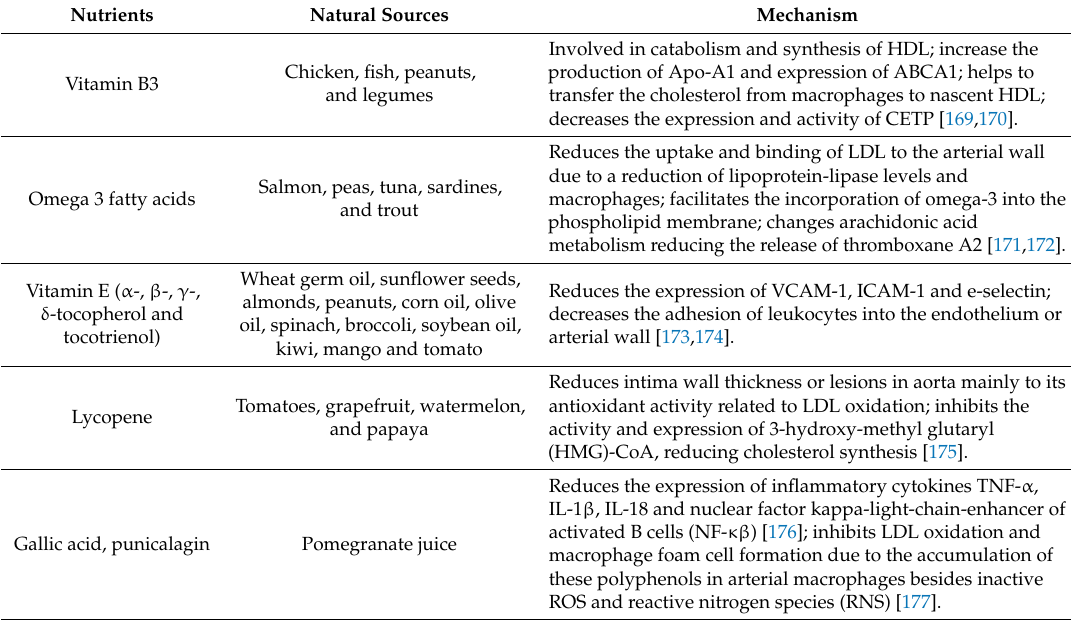
Table 3. Nutrients with cardioprotective